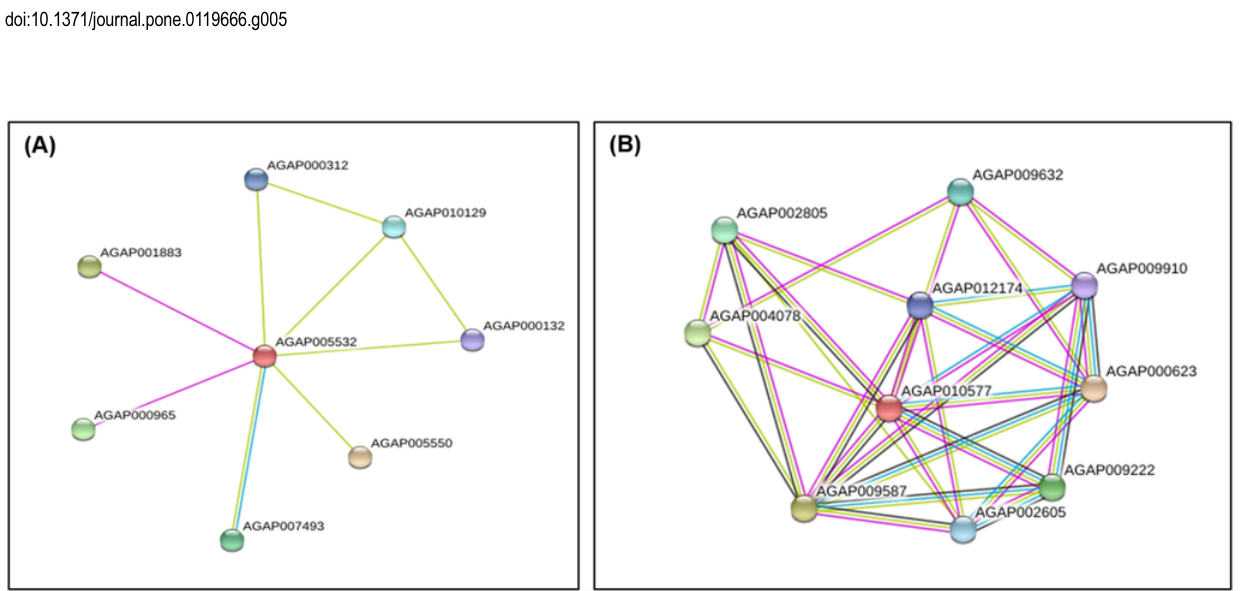
Fig 6. Evidence view of upregulated proteins in resistant strain showing interaction with other proteins. (A) SDR protein (AGAP005532) (B) Tyrosyl DNA phosphodiesterase. Different line colors represent the types of evidence for the association. Green color depicts neighborhood; red color: gene fusion; pink color: experiments; light green color: text mining; blue color: co-occurrence; dark blue color: co-expression; purple color: homology. Circle nodes indicated different proteins.